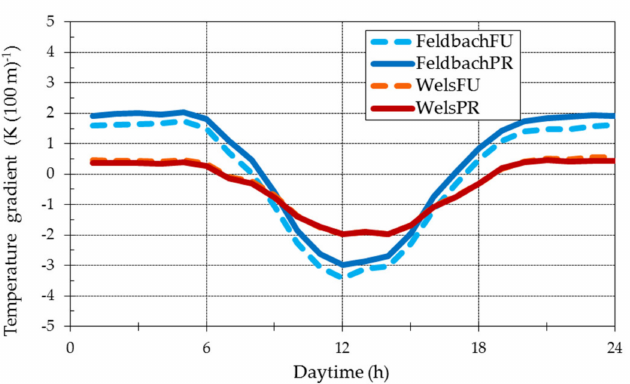
Figure 4. Annual mean of the daily course of the vertical temperature gradient (K (100 m) − 1 )